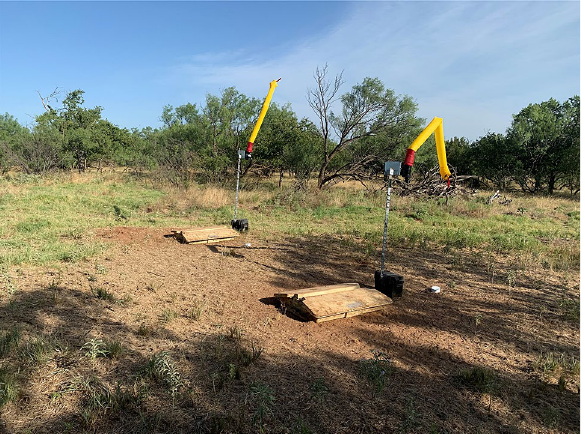
Figure 3. Example of activated deterrent devices (scare dancers) mounted above bait stations containing a sodium nitrite toxic bait in north-central Texas, USA during July 2020. Photo property of